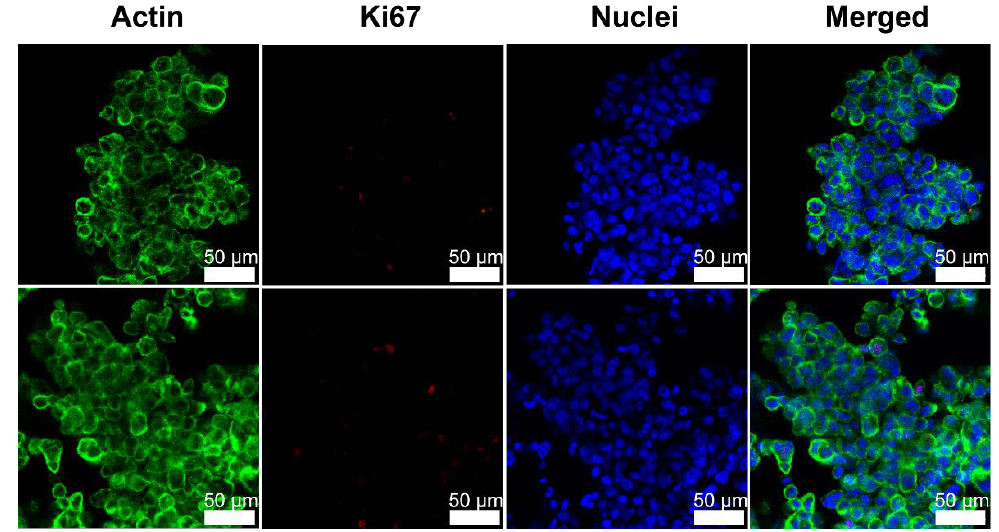
Figure 3. Immunocytochemical staining showing loose actin (green), proliferating cells (red), and nuclei (blue) of the 3D cultured prostate cancer (PC3) cell spheroids cultured either in 1.0% NFC hydrogel (control) or in freeze-dried and reconstituted 1.0% NFC hydrogel (sample). Green: Phalloidin conjugated Alexa Fluor 488. Red: Alexa Fluor 594. Blue: DAPI. HepG2 cell spheroids grew with mass spheroid morphology in the 0.8% NFC hydro-